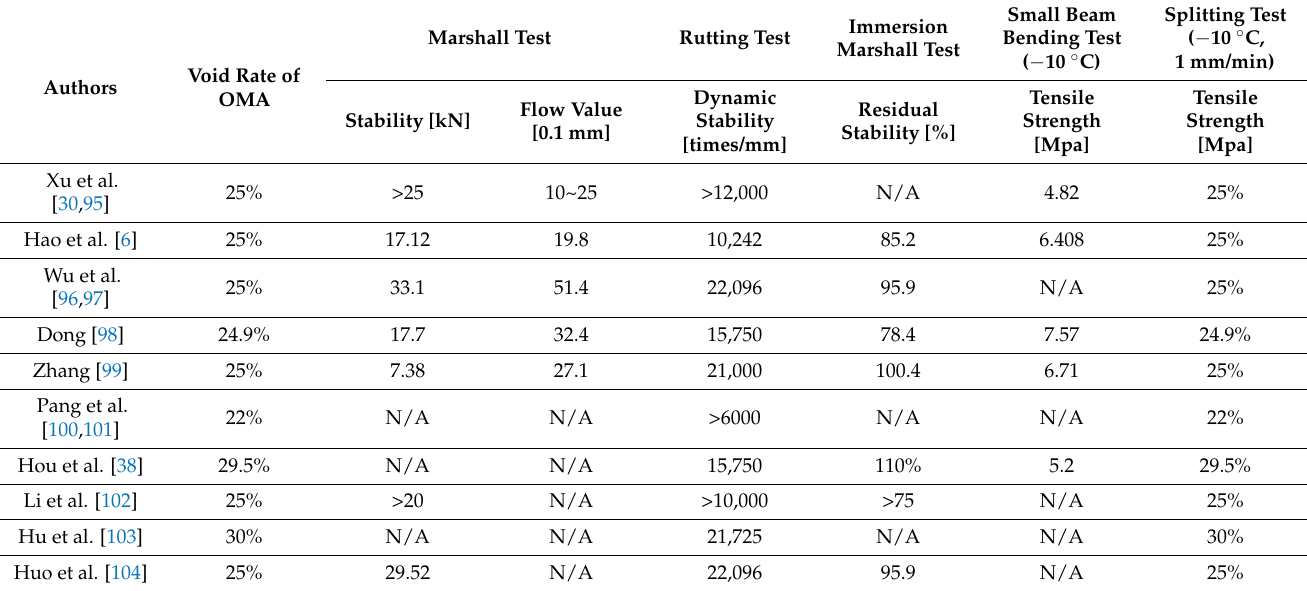
Table 10. Traditional laboratory tests and performance of